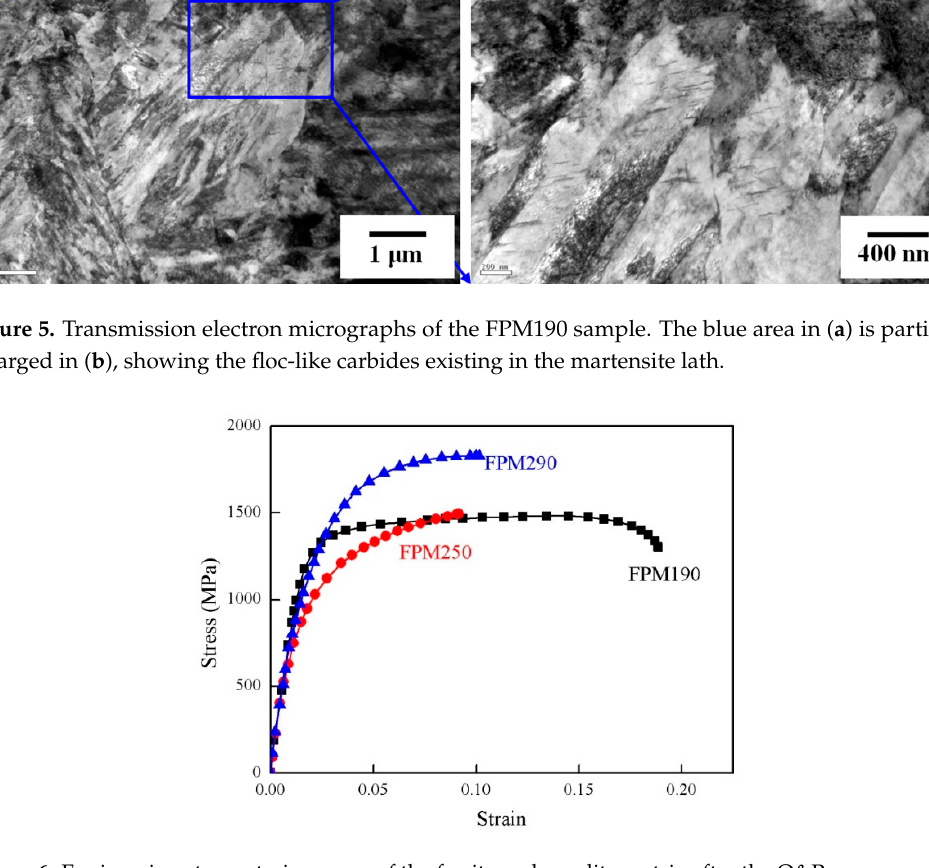
Figure 6. Engineering stress-strain curves of the ferrite and pearlite matrix after the Q&P process under different quenching temperatures.